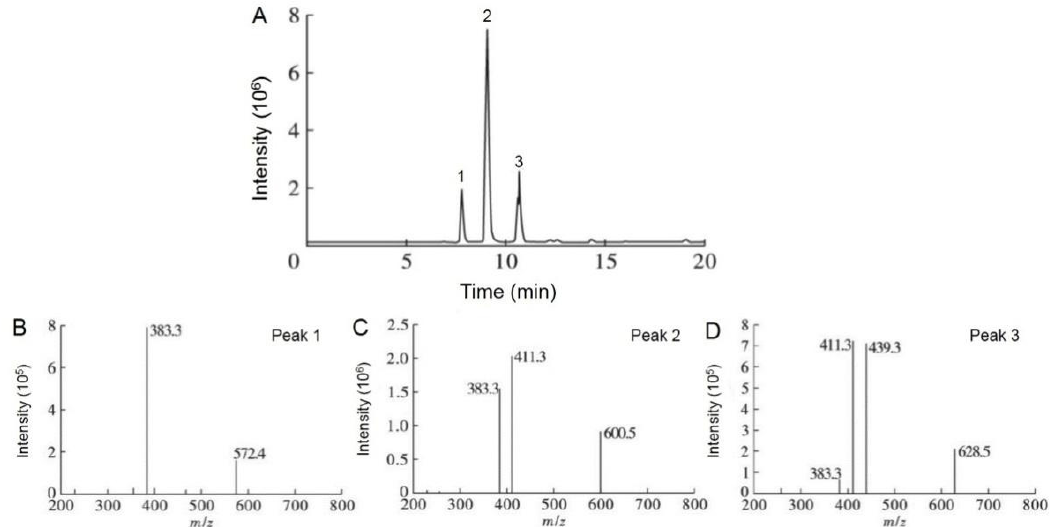
Figure 1. Total ion chromatogram ( A ) and MS/MS spectra ( B – D ) of